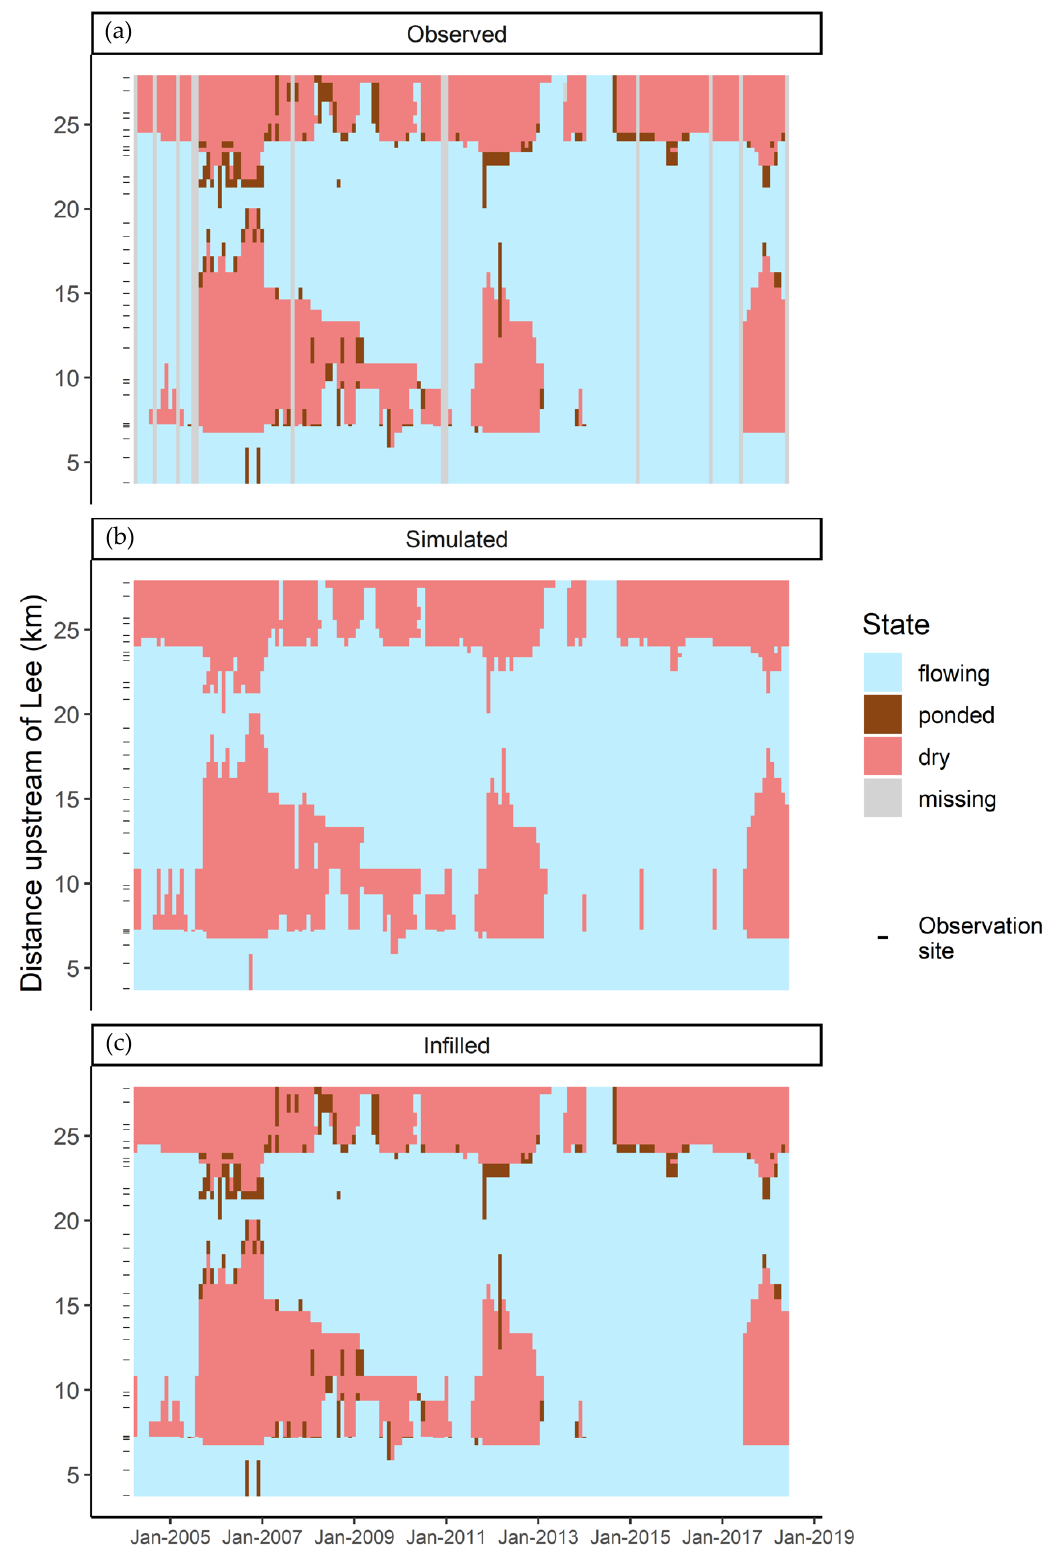
Figure 6. Monthly time series of observed ( a ), simulated ( b ), and infilled ( c ) hydrological state on the Misbourne, where infilled states are observations where available and simulations where observations are unavailable. Hydrological state is assumed to be consistent along observed reaches due to the high spatial resolution of the data.